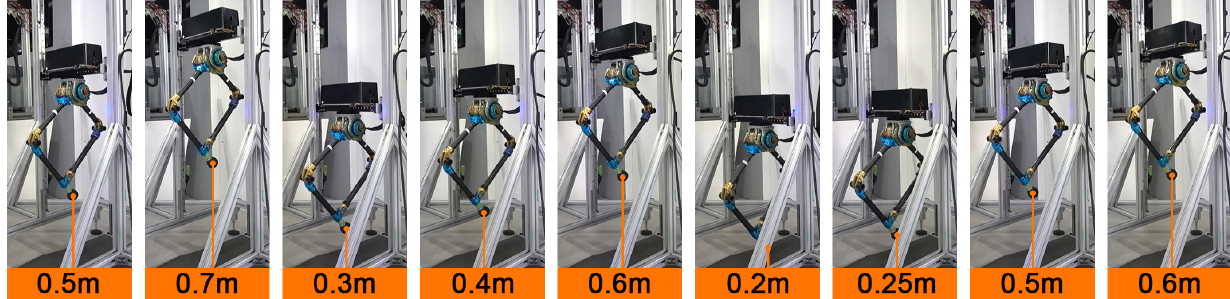
Figure 12. Photographs of robot leg hopping to different summit heights. Distance values in the images are measured from ground to toe.